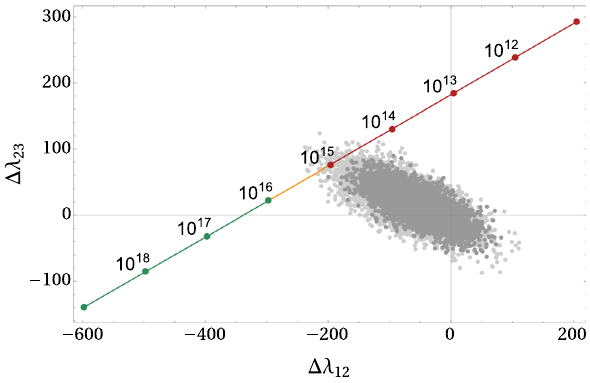
Fig. 3 Possible threshold corrections in an SU ( 5 ) GUT with scalars Fig. 4 Possible threshold corrections in an SO ( 10 ) GUT with scalars in the 5 ⊕ 10 ⊕ 15 ⊕ 23 ⊕ 45 ⊕ 50 representation. The gray points in the 10 ⊕ 120 ⊕ 126 ⊕ 45 representation. The gray points indicate the indicate the values for (cid:8)λ 23 (μ) over (cid:8)λ 12 (μ) for randomized mass values for (cid:8)λ 23 (μ) over (cid:8)λ 12 (μ) for randomized mass spectra of the , 2 ] . The light gray spectra of the superheavy particles with R ∈ [ 1 , 2 ] . The light gray points correspond superheavy particles with R ∈ [ 1 10 10 , 2 ] . Neither with R ∈ [ 1 , 2 ] nor with points correspond to R ∈ [ 1 , 2 ] . While unification is not possible with R ∈ [ 1 , 2 ] , to R ∈ [ 1 20 10 20 10 , 2 ] configurations exist that could explain the non-unification R ∈ [ 1 , 2 ] . However, the there are some viable configurations with R ∈ [ 1 20 20 of the gauge coupling (cid:11) 10 15 . 3 GeV, implies corresponding maximal SO ( 10 ) scale M max SO ( 10 ) a proton lifetime significantly below the present bound (Eq.